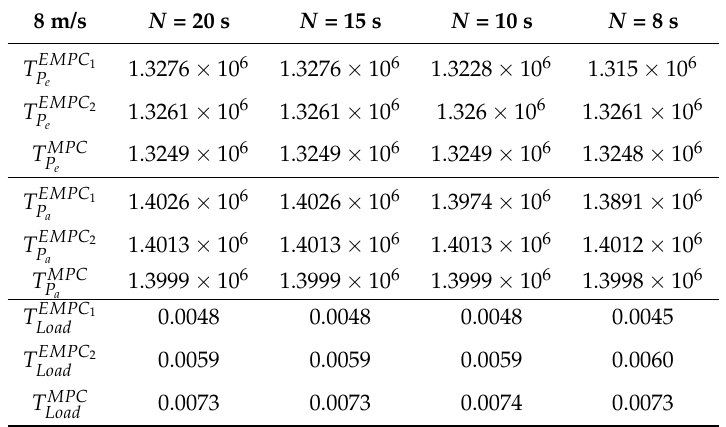
Figure 14. Performance P e and P a for the proposed EMPC 1 (black dash-dotted line), EMPC 2 (red solid line) and classical tracking MPC (green dashed line) under turbulent wind. Table 4. Average economic performance for different prediction horizon at an average wind speed of 8 m/s.